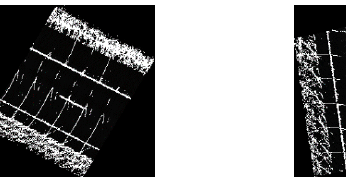
Figure 8. Typical LiDAR intensity images from source domain datasets belonging to two-lane highway areas.